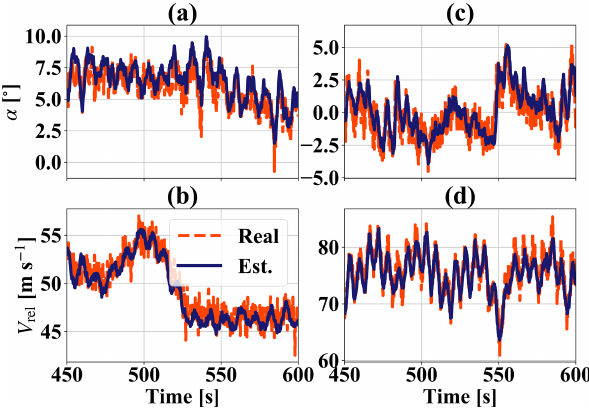
Figure 7. Time series of the estimator performance for two different turbulent wind speed simulations. (a) α for V hub = 7ms − 1 ; (b) V rel for V hub = 7ms − 1 ; (c) α for V hub = 15ms − 1 ; (d) V rel for V hub = 15ms − 1